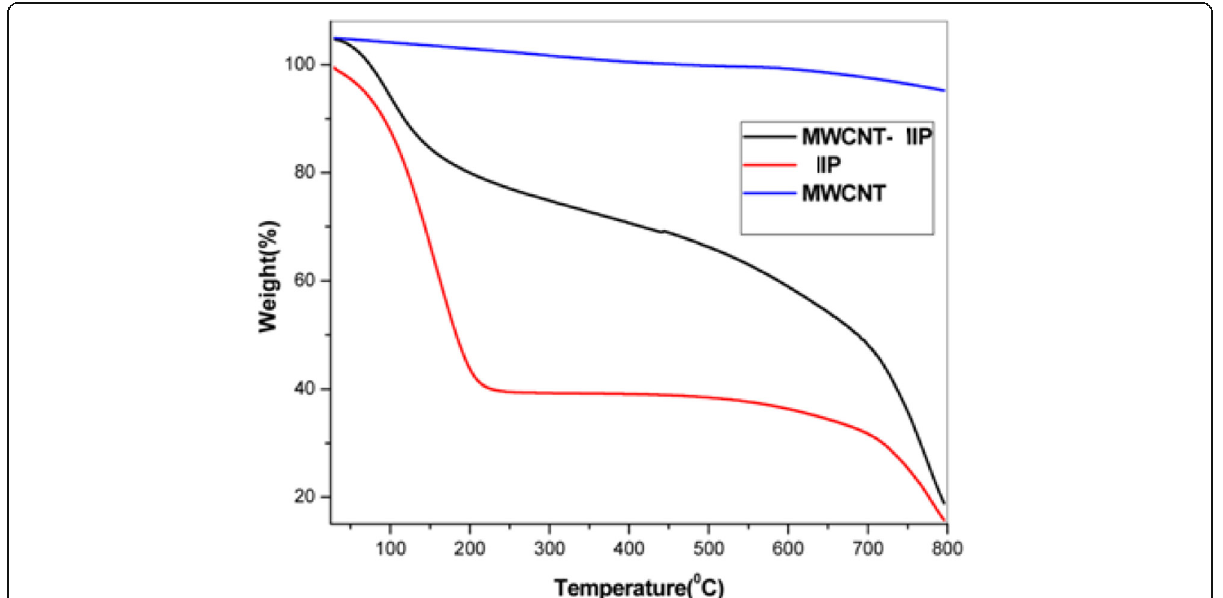
Fig. 3 Thermo gram of a MWCNT-IIP, b IIP, and c MWCNT